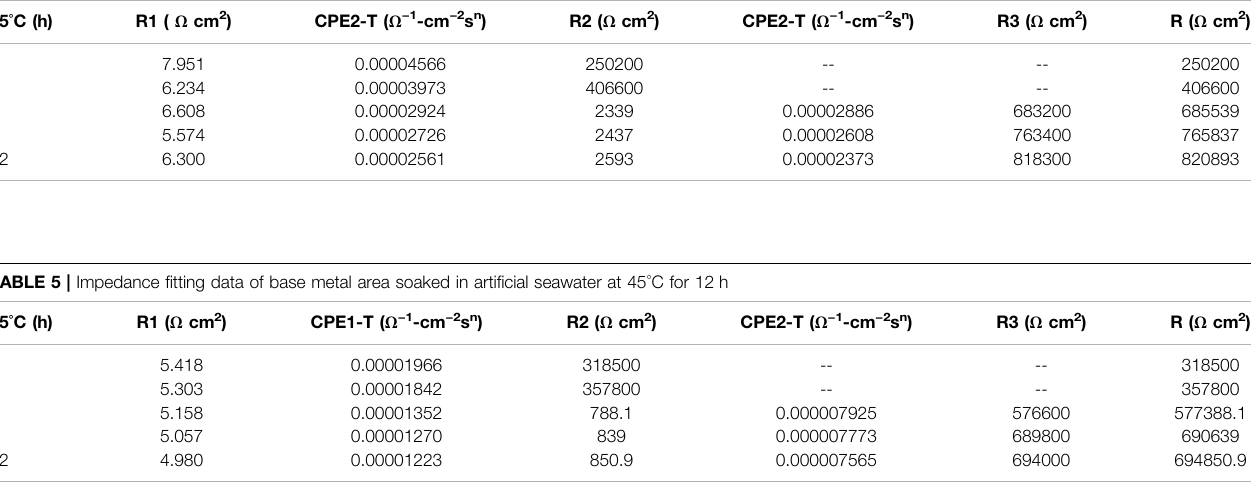
indicate the formation of passivation fi lm, which is fi tted with Figure 3B . Zsimpwin software was used to fi t the obtained data, and the obtained data were listed in Tables 9 , 10 , 11 below. The